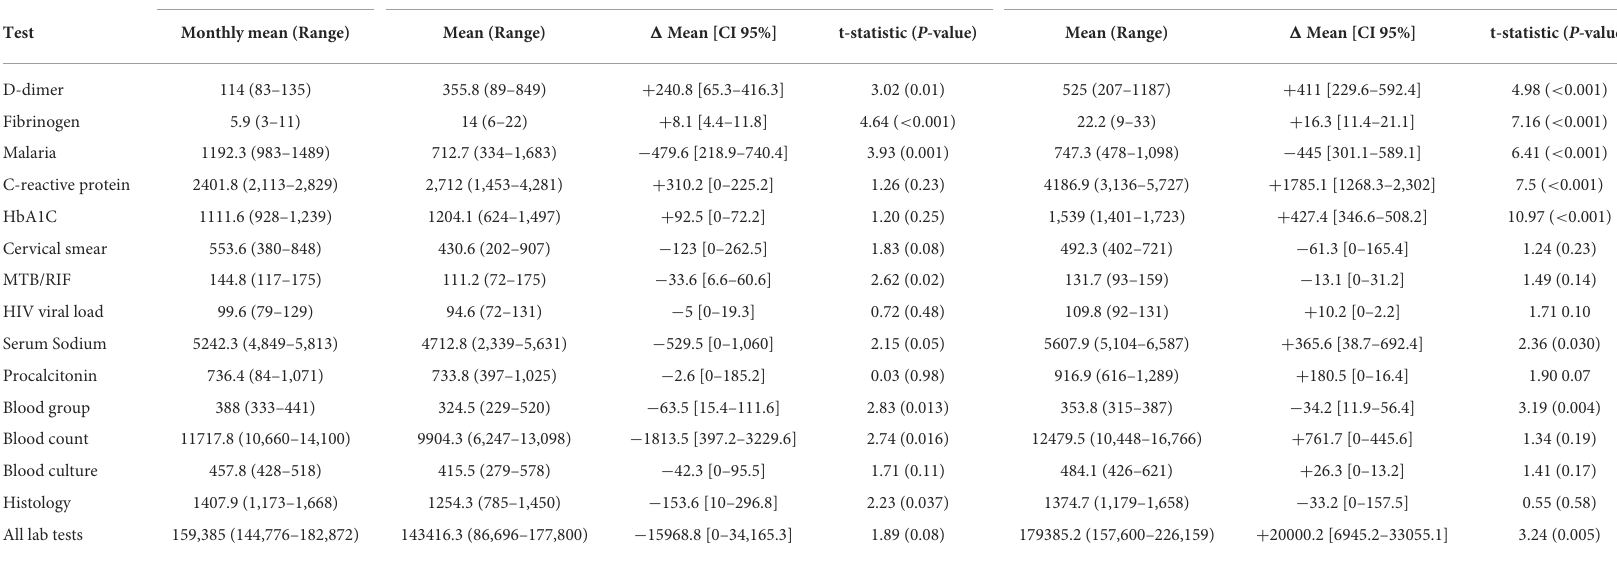
TABLE 1 Table showing analysis of the changes in laboratory test in 2020 and 2021 compared to 2019